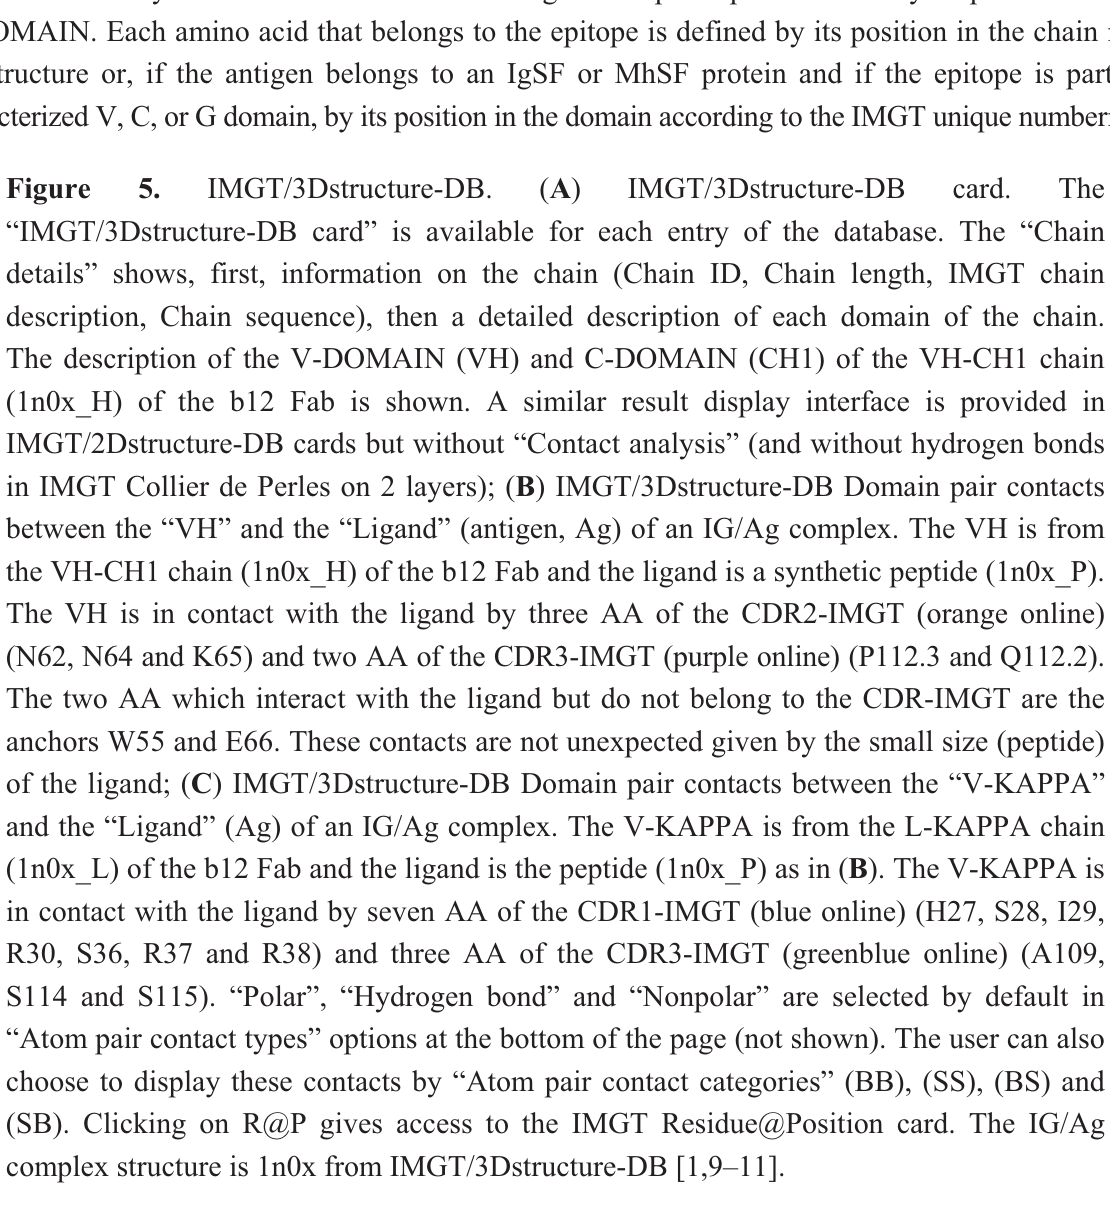
Figure 5. IMGT/3Dstructure-DB. ( A ) IMGT/3Dstructure-DB card.